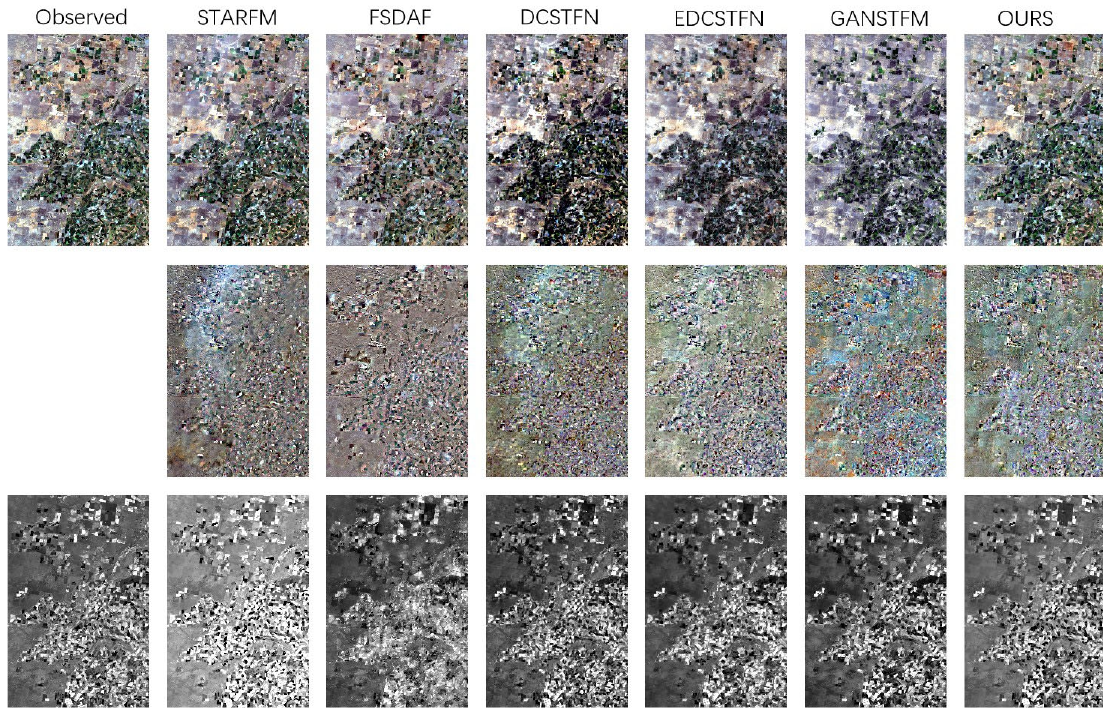
Figure 9. The global rendering result of the CIA